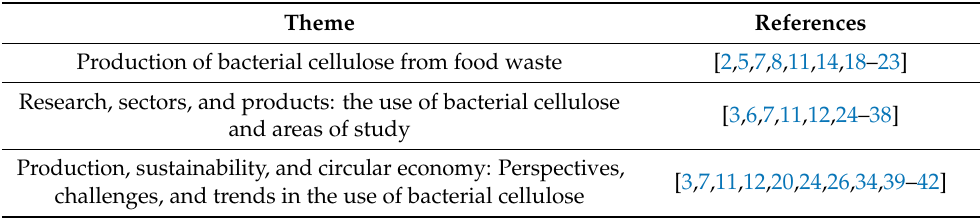
Table 1. Topics covered and the respective references.